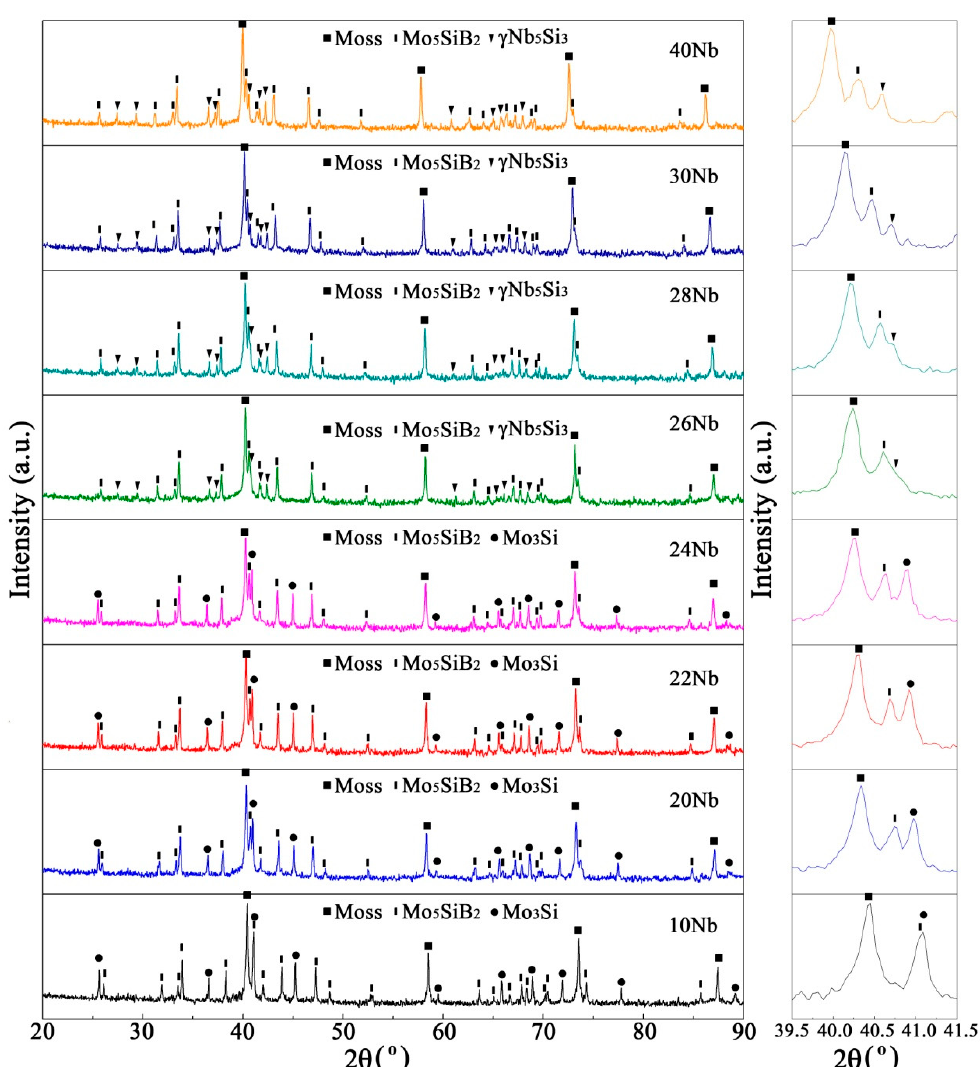
Figure 6. XRD spectra (logarithmic Y-axes) of samples S-xNb/30h (x=10, 20, 22, 24, 26, 28, 30, and 40). Inset: enlarged view in the 2 θ range from 39.5° to 41.5° containing Mo(110), Mo 5 SiB 2 (213), and Mo 3 Si(210) or γ Nb 5 Si 3 (211) peaks.